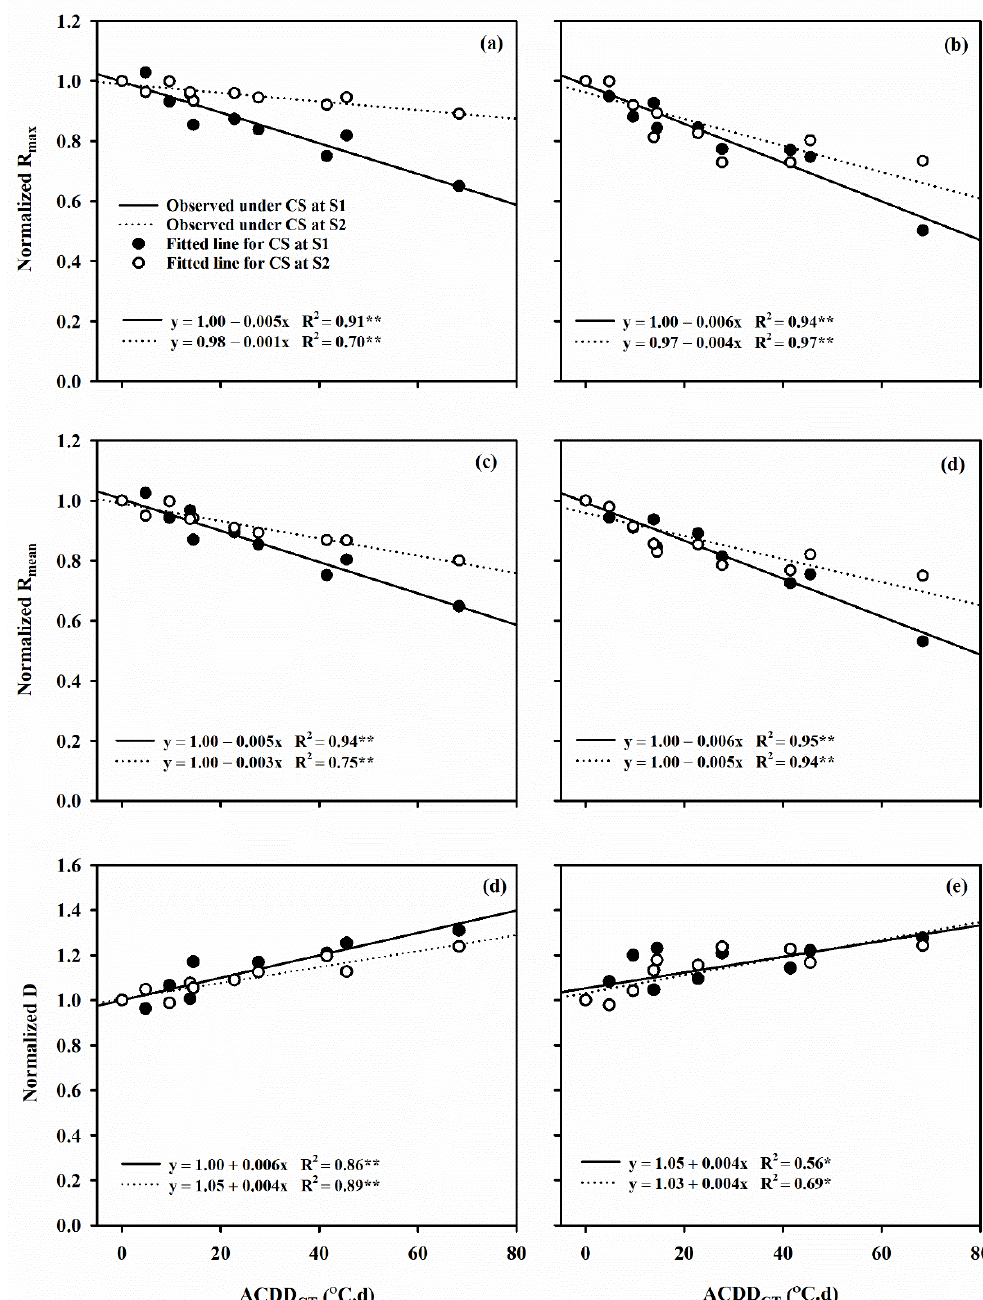
Figure 6. The relationship between the change in canopy temperature based accumulated cold degree days (ACDD CT ) and the relative change in ( a , b ) maximum filling rate (R max ), ( c , d ) mean filling rate (R mean ) and ( e , f ) total days from flowering to 95% SW m (D) in Huaidao 5 and Nanjing 46, respectively. (S1) Flowering stage; (S2) grain filling stage. Capital letters represent Huaidao 5 whereas the small letters represent Nanjing 46. ** represents p < 0.01; * represents p < 0.05).